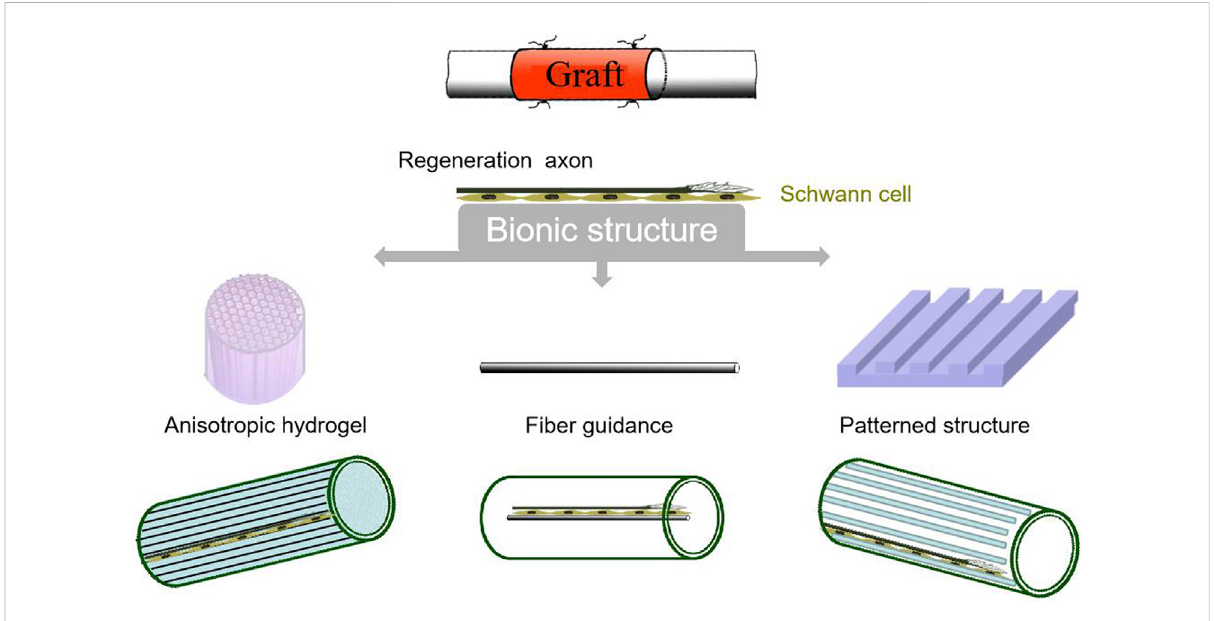
FIGURE 1 Strategies for constructing bionic structures of grafts.